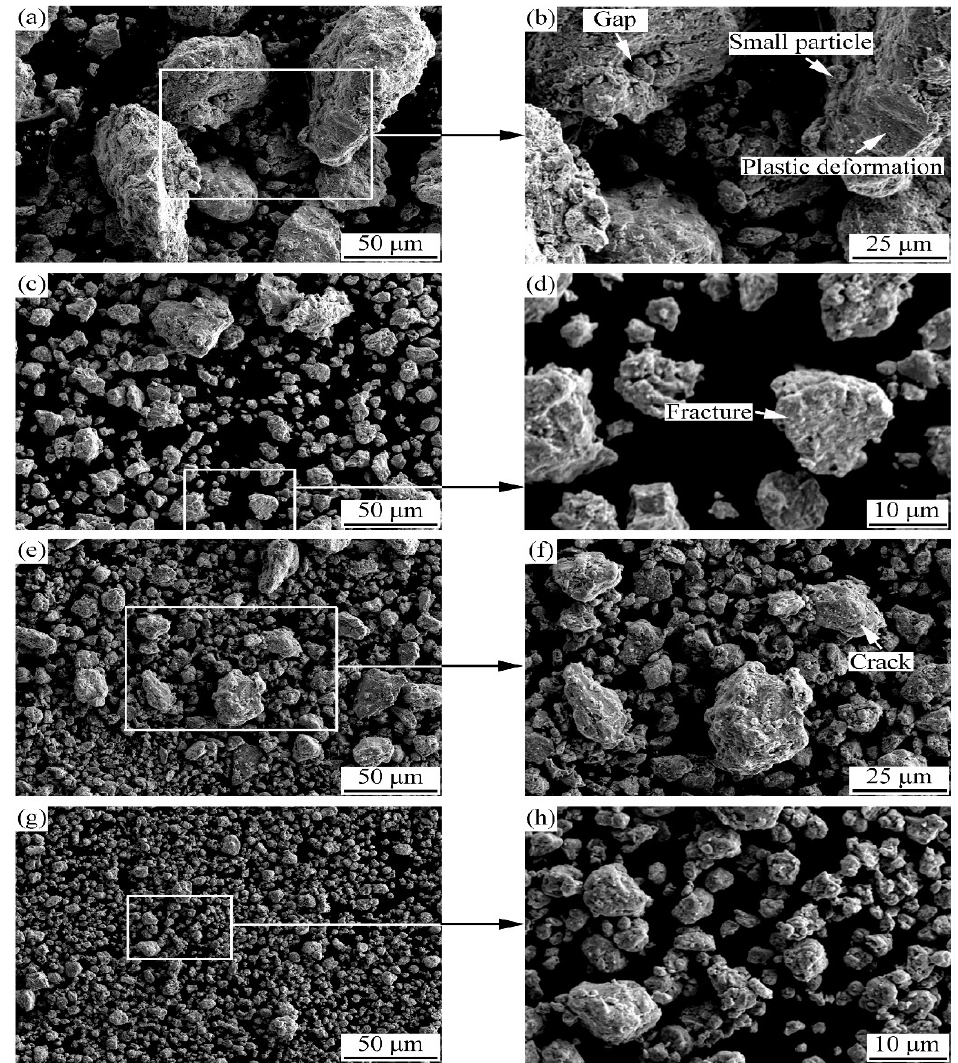
Figure 13. Size reduction processes arc melted AlCoCrFeNiSi alloy at different milling times: ( a , b ) 5 h; ( c , d ) 10 h; ( e , f ) 20 h; ( g , h ) 30 h. Reprinted with permission from [143] Copyright 2019 Elsevier.